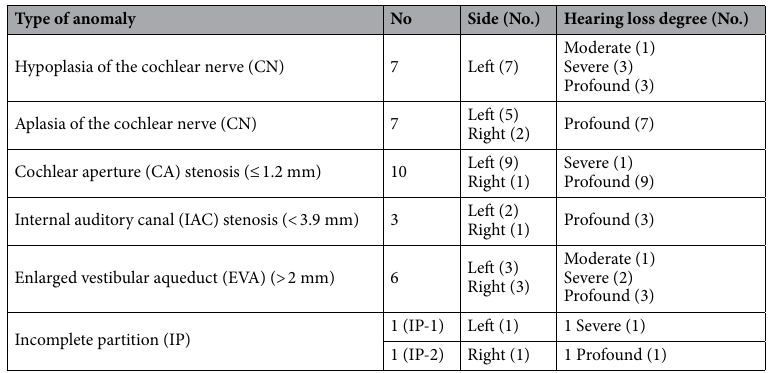
Table 2. The table summarizes the type of anomaly, the side and the degree of hearing loss of the 18 patients with inner ear malformations. Hypoplasia/aplasia of the cochlear nerve and cochlear aperture stenosis were the most frequent overlapping conditions (10